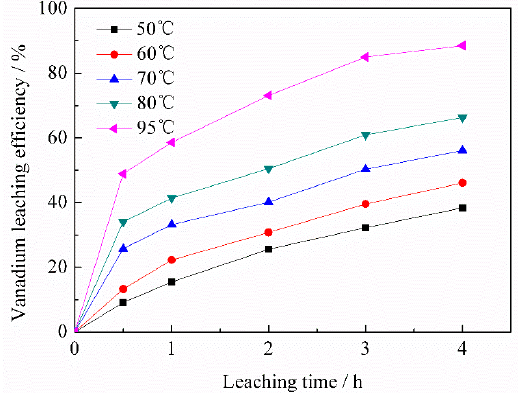
Figure 9. Effect of leaching temperature on vanadium leaching efficiency.